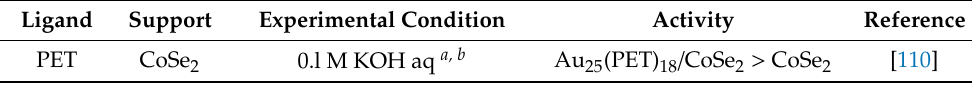
Figure 6. (A, B) HAADF-STEM images of Au 25 (PET) 18 /CoSe 2 composite at different magnifications. Figure 6. ( A , B ) HAADF-STEM images of Au 25 (PET) 18 / CoSe 2 composite at di ff erent magnifications. (C, D) OER polarization curves of CoSe 2 , Au 10 (SPh- t Bu) 10 /CoSe 2 , Au 25 (PET) 18 /CoSe 2 , ( C , D ) OER polarization curves of CoSe 2 , Au 10 (SPh- t Bu) 10 / CoSe 2 , Au 25 (PET) 18 / CoSe 2 , Au 144 (PET) 60 /CoSe 2 , Au 333 (PET) 79 /CoSe 2 , and Pt NP /CB (CB = carbon black). (E) Co 2p XPS spectra and Au 144 (PET) 60 / CoSe 2 , Au 333 (PET) 79 / CoSe 2 , and Pt NP / CB (CB = carbon black). ( E ) Co 2p XPS spectra (F) Raman spectra of CoSe 2 and Au 25 (PET) 18 /CoSe 2 composite. Panels (A–F) are reproduced with and ( F ) Raman spectra of CoSe 2 and Au 25 (PET) 18 / CoSe 2 composite. Panels ( A – F ) are reproduced with permission from reference [110]. Copyright American Chemical Society, 2017. permission from reference [110]. Copyright American Chemical Society, 2017. Table 2. Representative reference on OER activity of Au n (SR) m